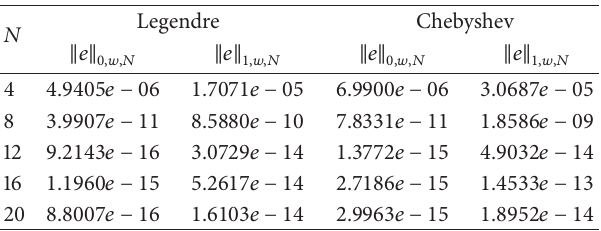
Table 3: Error discretization for Example 1 with ] = 0 and different polynomial order